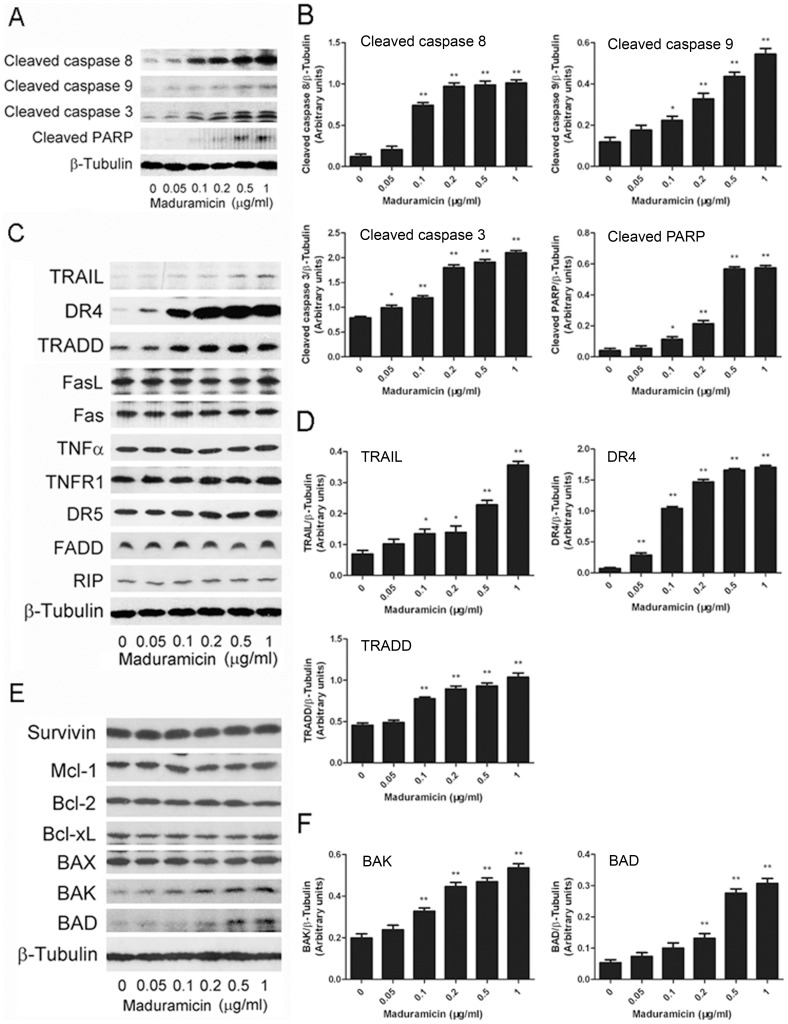
Maduramicin upregulates expression of DR4, TRADD, TRAIL, BAK and BAD, leading to activation of caspases 8, 9 and 3 as well as cleavage of PARP in C2C12 cells.C2C12 cells were treated with maduramicin for 24 h at indicated concentrations, followed by Western blotting with indicated antibodies. β-Tubulin was used for loading control. Representative blots are shown (A, C and E). Blots for indicated proteins were semi-quantified using NIH image J (B, D and F). Results are presented as means ± SE (n = 3, corresponding to three independent experiments). *P<0.05, **P<0.01, difference with the control group.